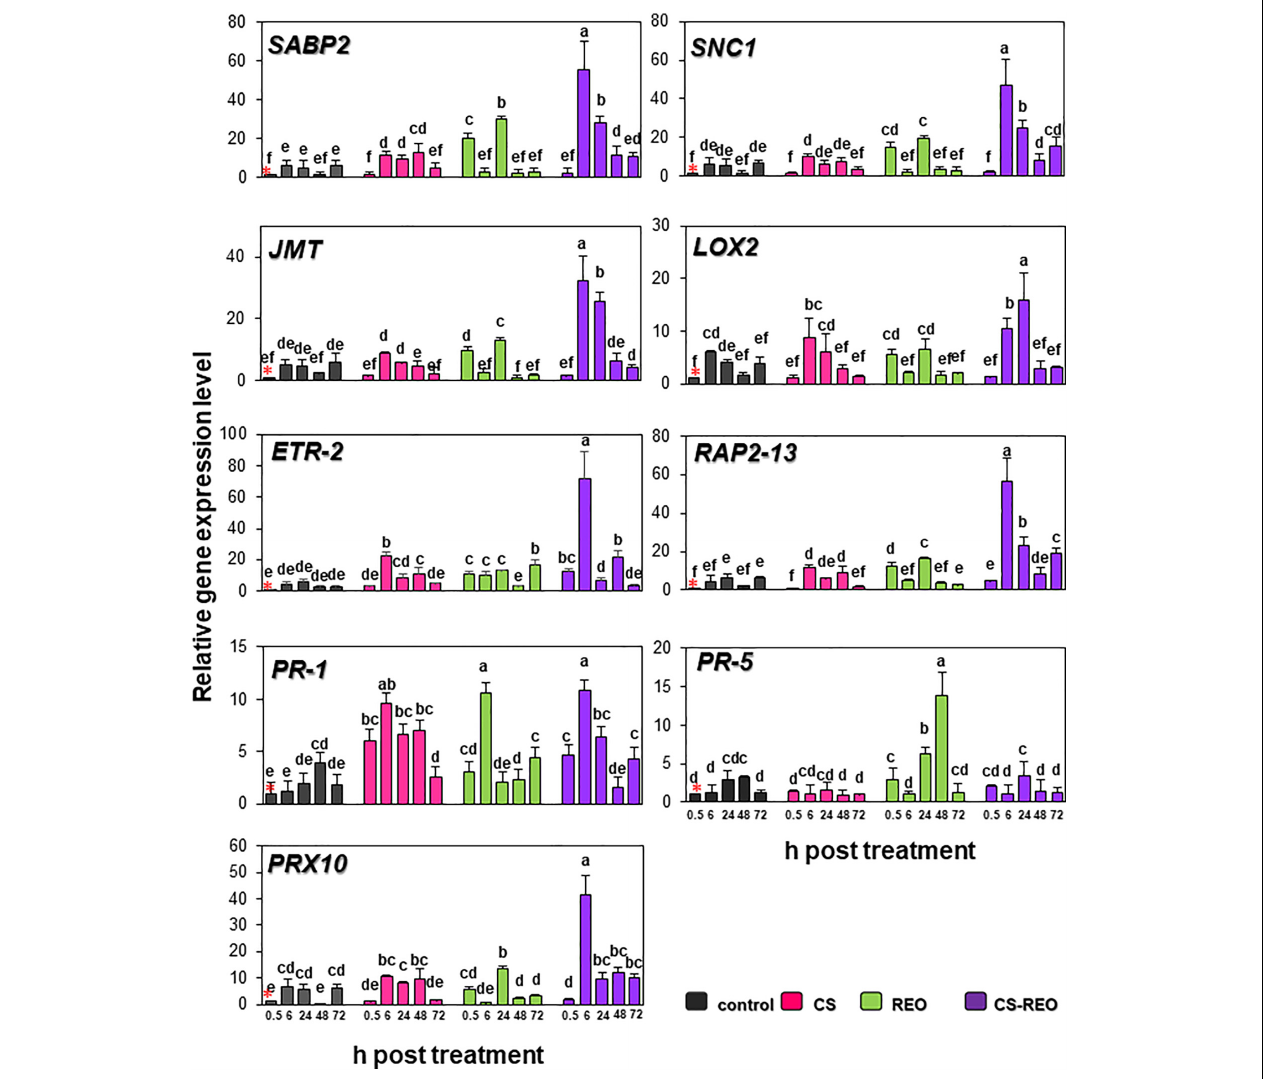
FIGURE 2 | Quantification of relative gene expression of nine of the defense genes examined (as indicated; see also Table 1 ) in papaya fruit following treatments with water (control), 0.5% CS, 0.5% REO, and their combination (CS-REO). Each experimental replicate represents three technical replicates ( n = 6). Gene expression given was relative to control at 0.5 h posttreatment, also indicated with a red asterisk, according to the 2 − (cid:49)(cid:49) Ct method (Livak and Schmittgen, 2001). Data are the means ± SD. Columns with different letters are significantly different ( P ≤ 0.05; Duncan’s multiple range